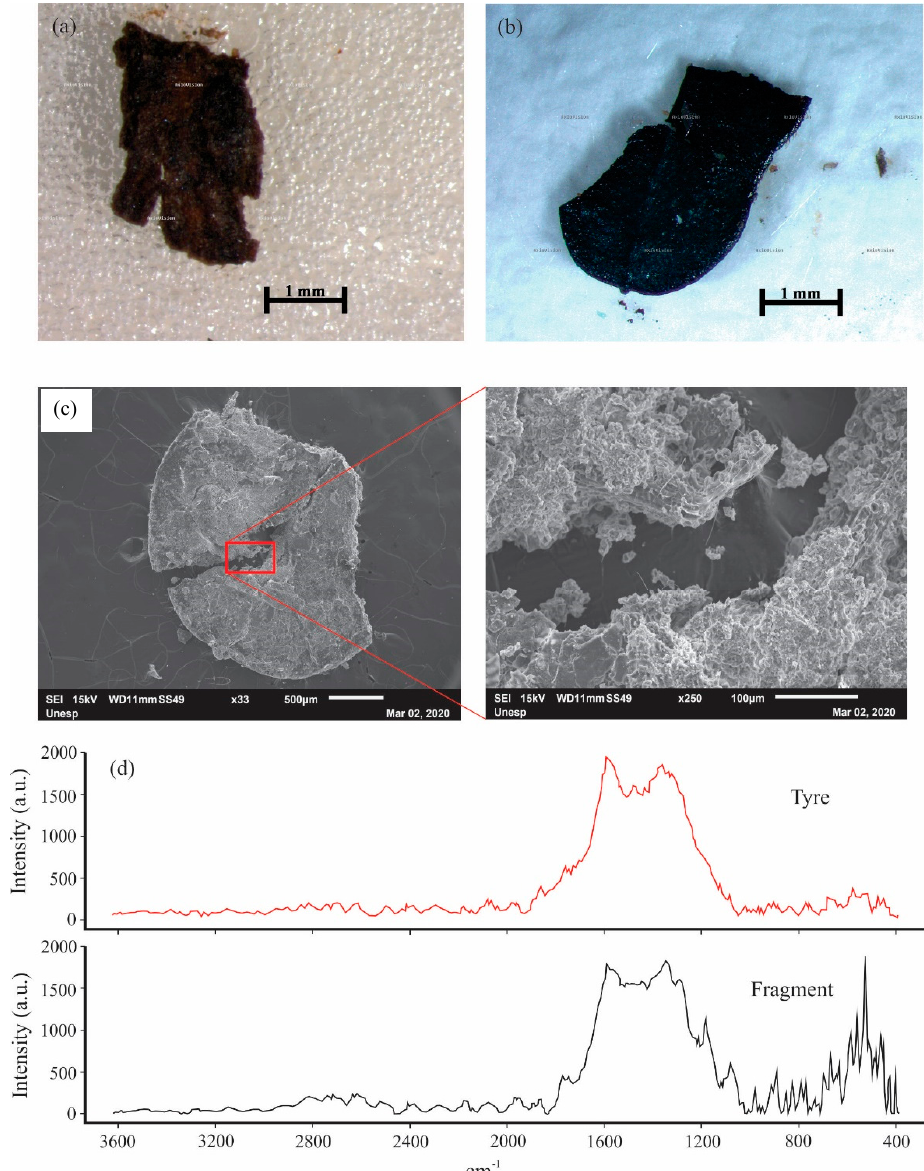
Figure 4. Types of MPs found in sediments from the SDR: ( a – d ) lines/fibres; ( e – h ) films and sheets, ( i – m ) fragments; and ( n , o ) pellets.